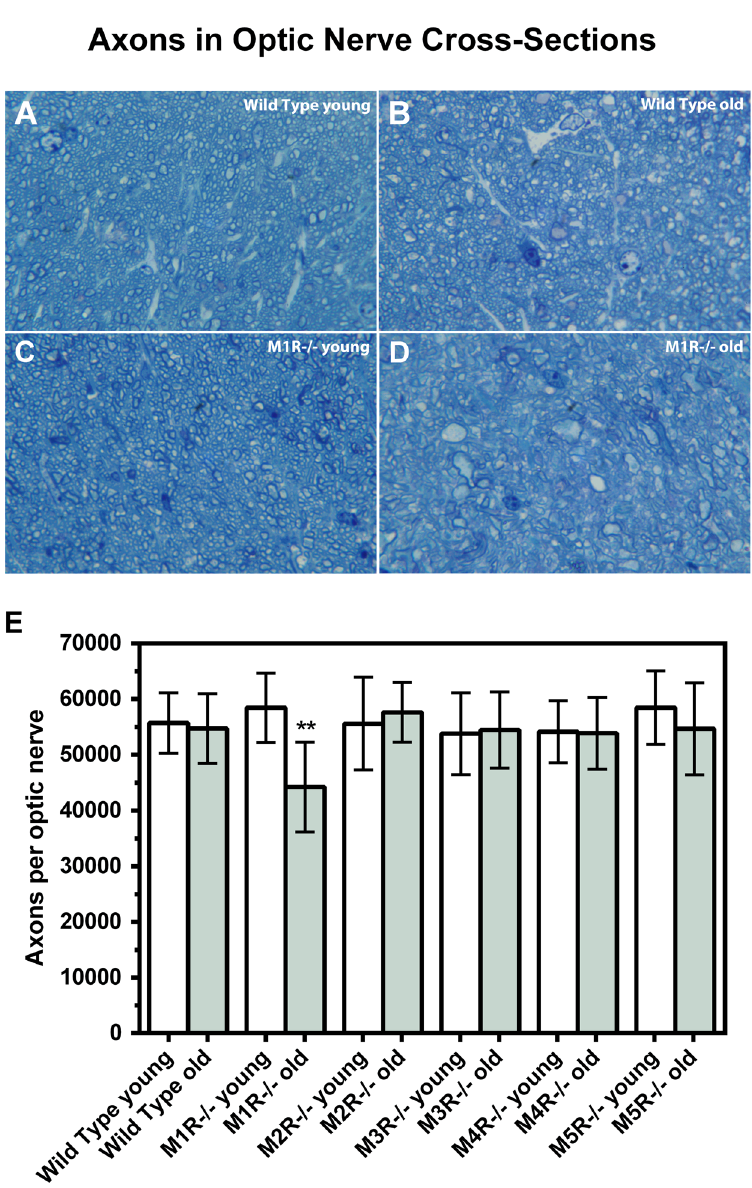
Figure 4. Example of photographs taken from optic nerve cross-sections of wild-type and M1R − / − mice. at both age categories ( A – D ; scale bars 10 µ m). The number of optic nerve axons was lower in old M1R − / − mice compared to younger mice of the same genetic background (D, ** p <